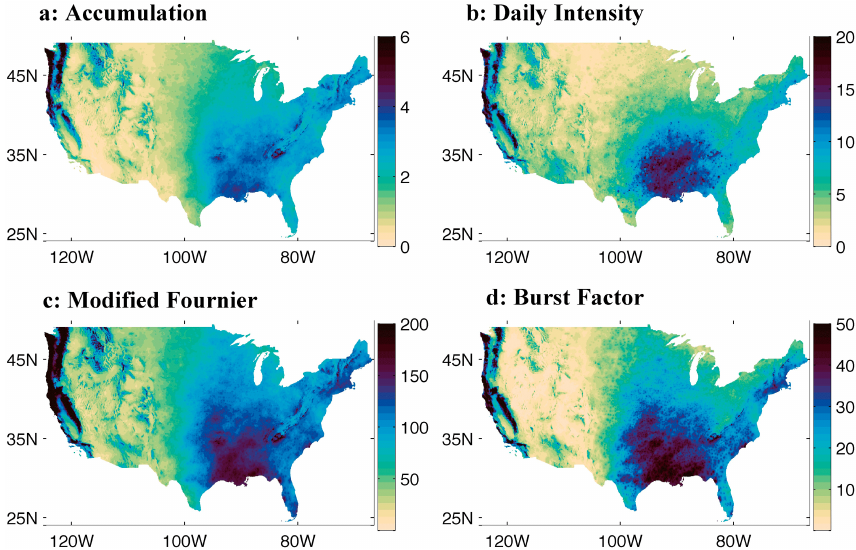
Figure 1. Observed rainfall characteristics for 1980–2000 in the PRISM data set (mmday − 1 ). (a) Mean annual accumulation. (b) Mean daily intensity (i.e., accumulation on rainy days, where a rainy day is any day with rain above 0mmday − 1 ). (c) Modified Fournier index, the sum of the squared monthly rainfall, divided by the annual rainfall. (d) Burst factor, the sum of the product of monthly rainfall accumulation with the maximum daily rainfall for the month, divided by the annual rainfall.